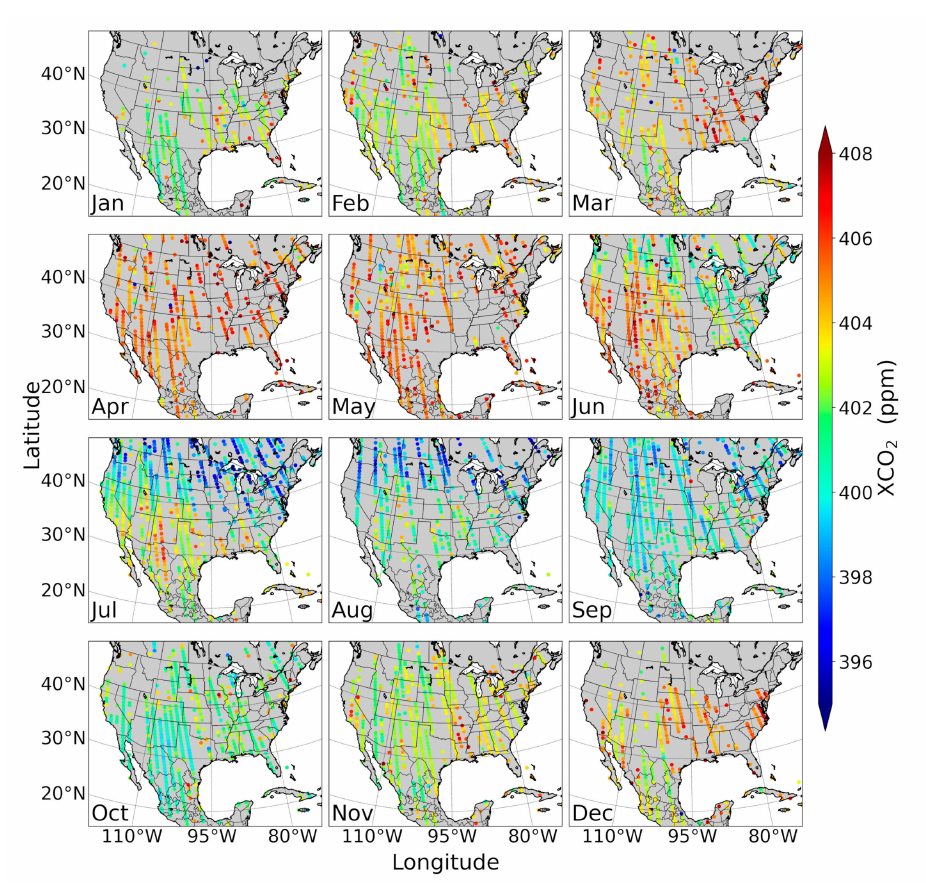
Figure 2. Representative mean XCO 2 retrievals of OCO-2 in each month of 2016 over the contiguous United